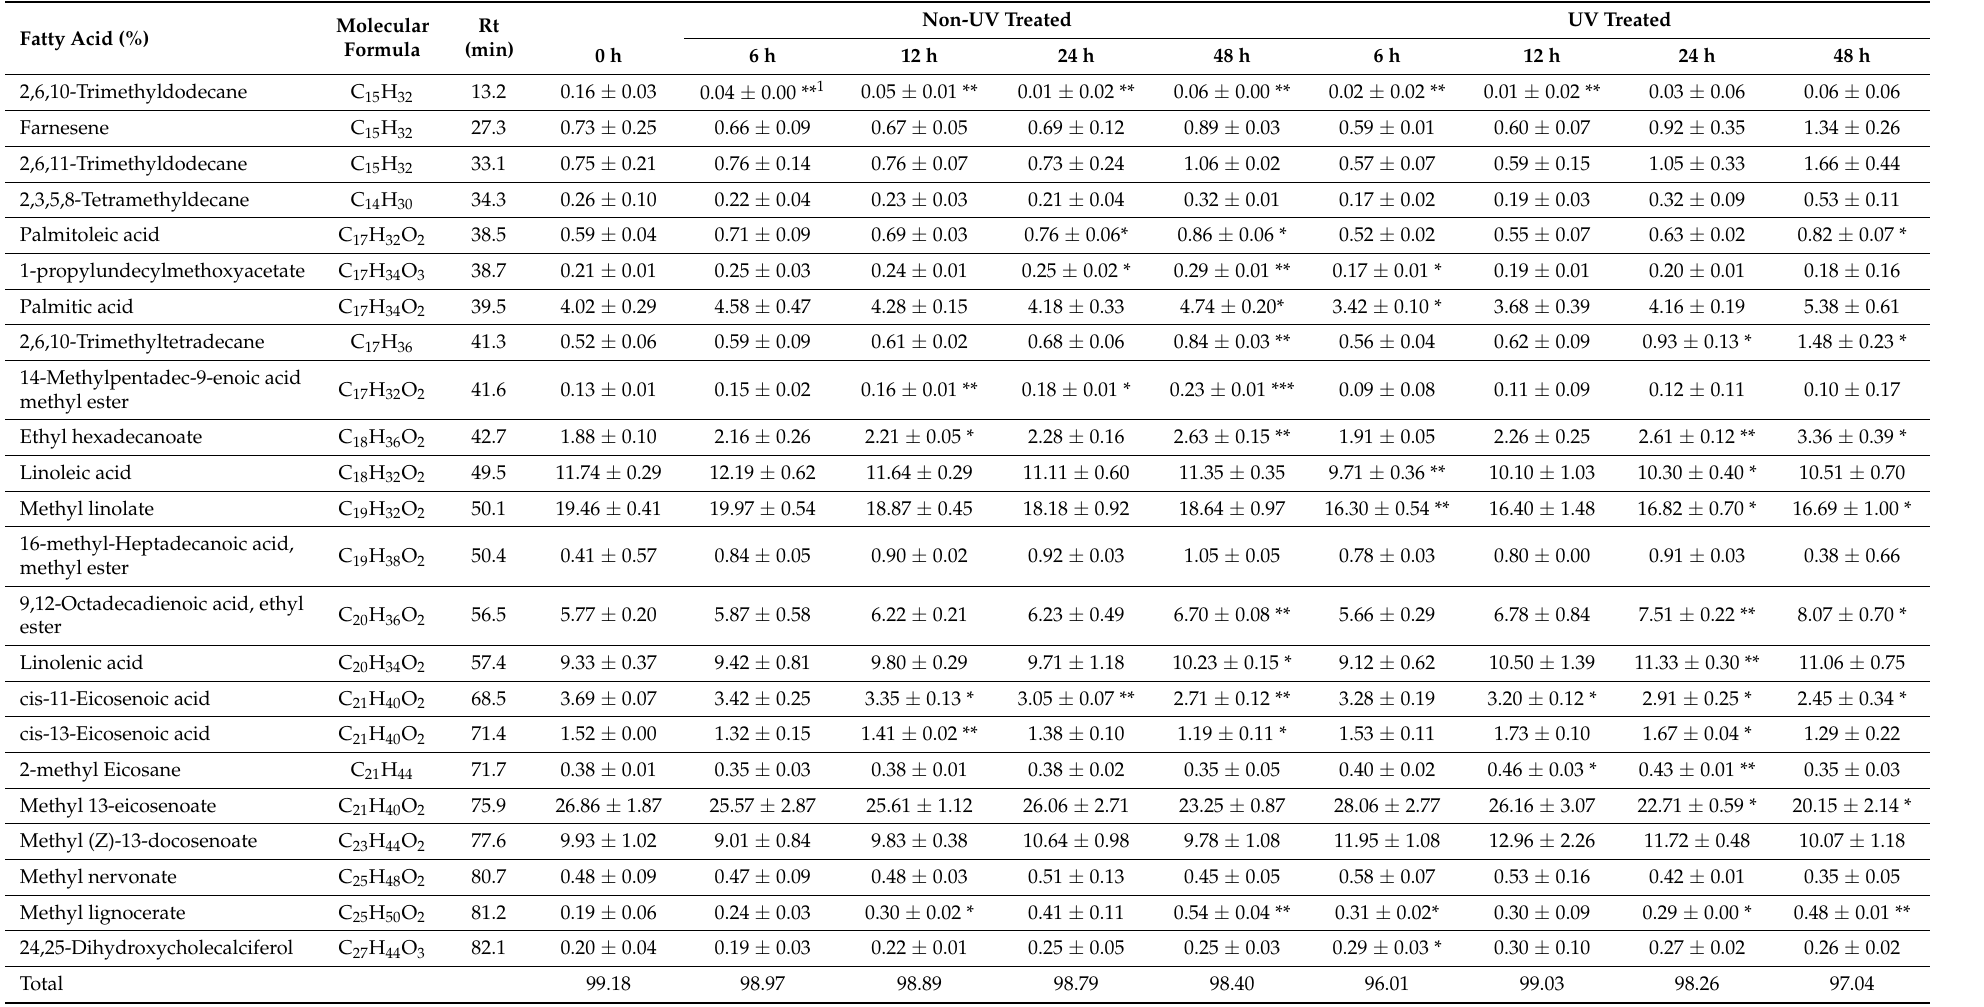
Table 2. Compositions (%) of fatty acids in UVB-treated purple kohlrabi